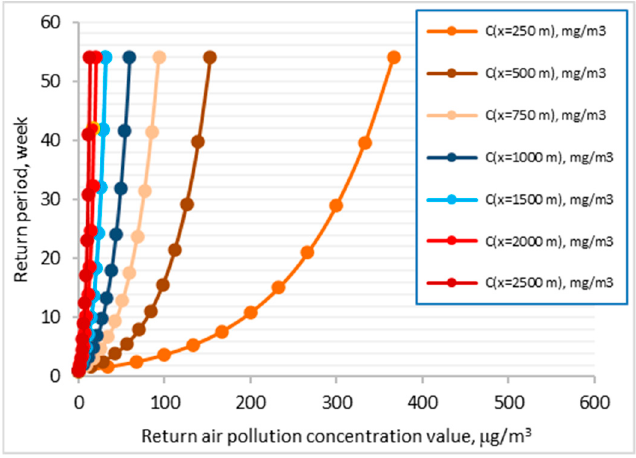
Figure 17. Air pollution concentration return value and period, NO